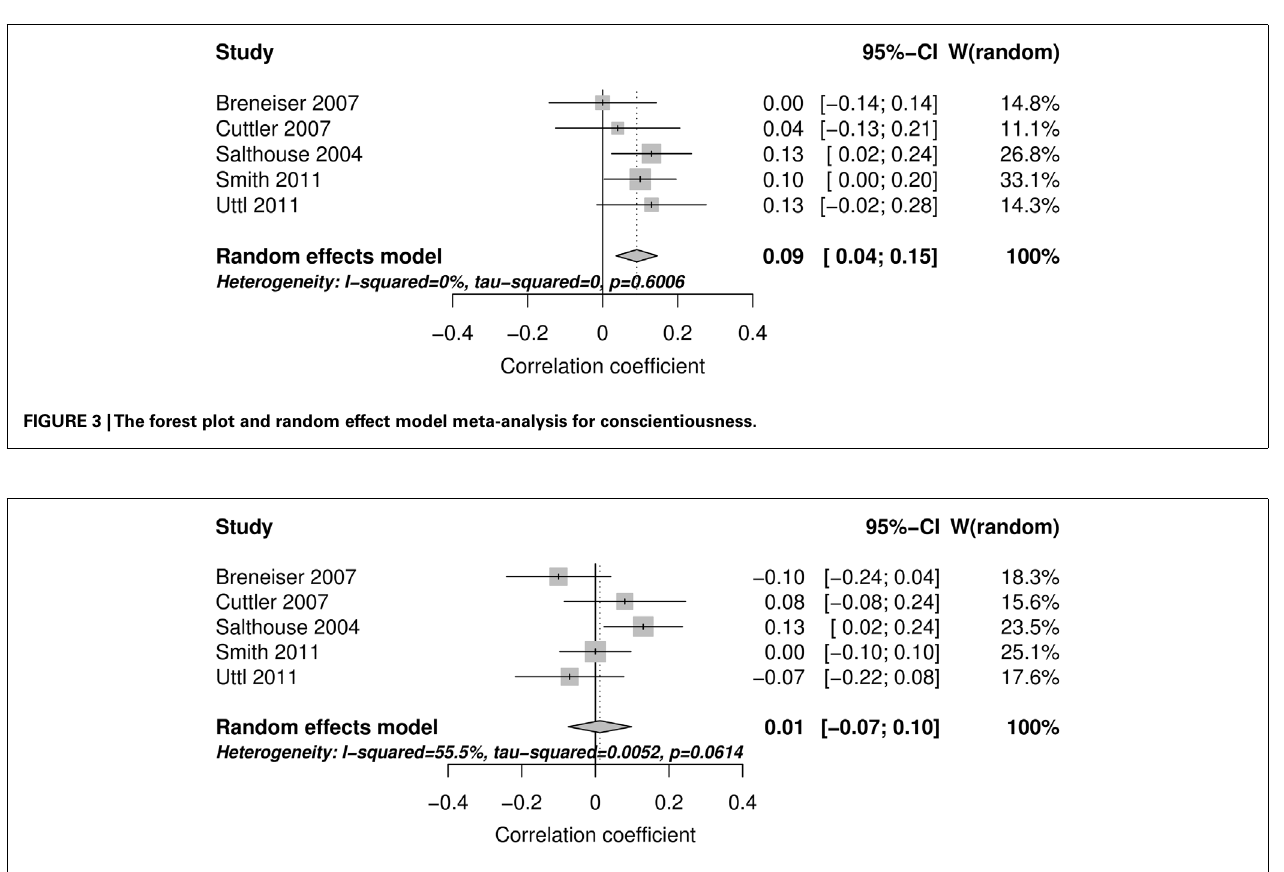
FIGURE 4 |The forest plot and random effect model meta-analysis for